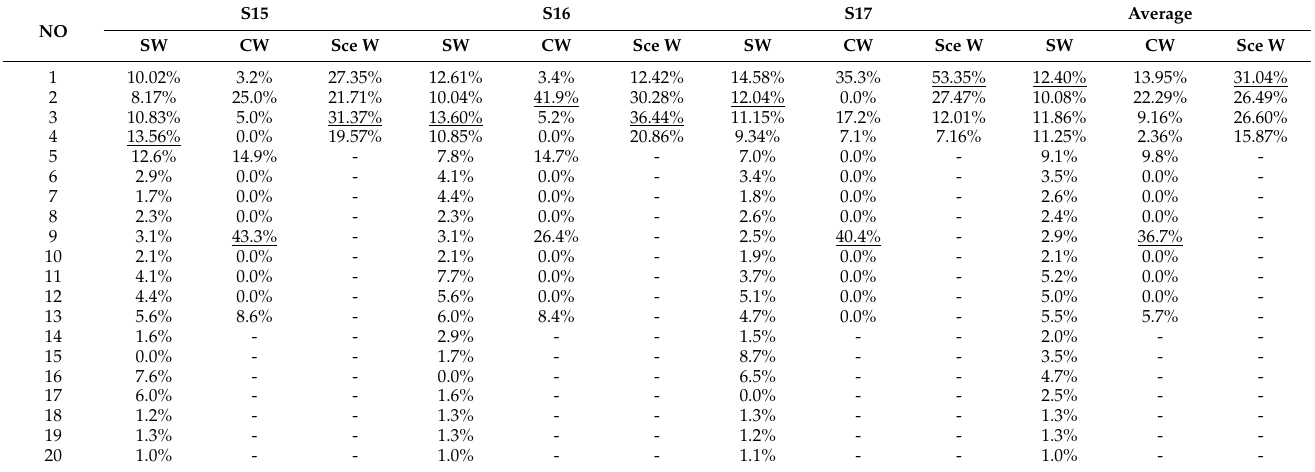
Table A5. Results of pairwise comparison of the Saaty scale (from − 9 to 9) for the local community